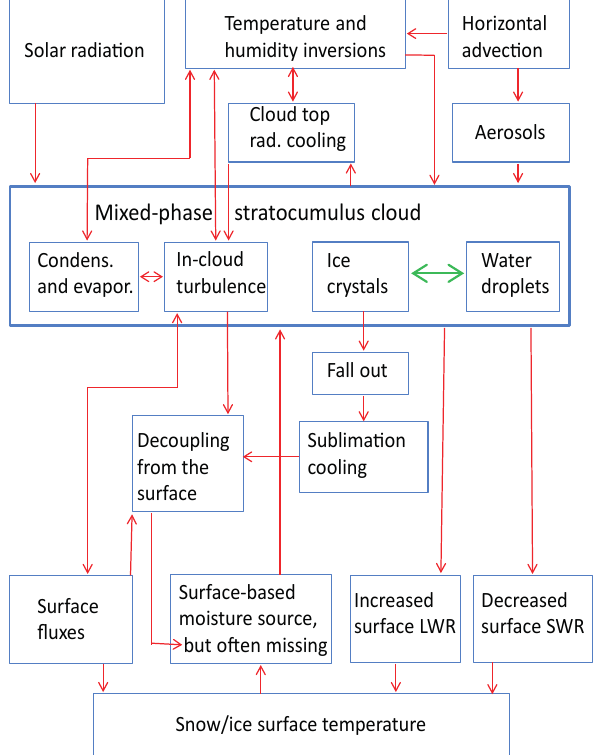
Figure 4. Schematic diagram on the effects and interactions related to mixed-phase stratocumulus clouds and radiative transfer. Macro- and microphysical processes and interactions are shown as arrows, the green arrow representing numerous microphysical processes re- lated to aerosols, nucleation, evaporation, depositional ice growth, cloud layer glaciation, and effects of saturation vapour pressure dif- ferences of liquid and ice (see e.g. Morrison et al.,